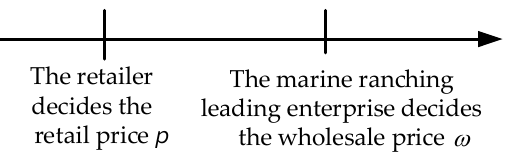
Figure 3. The game sequence of the leading enterprise and the retailer in Mode 2.